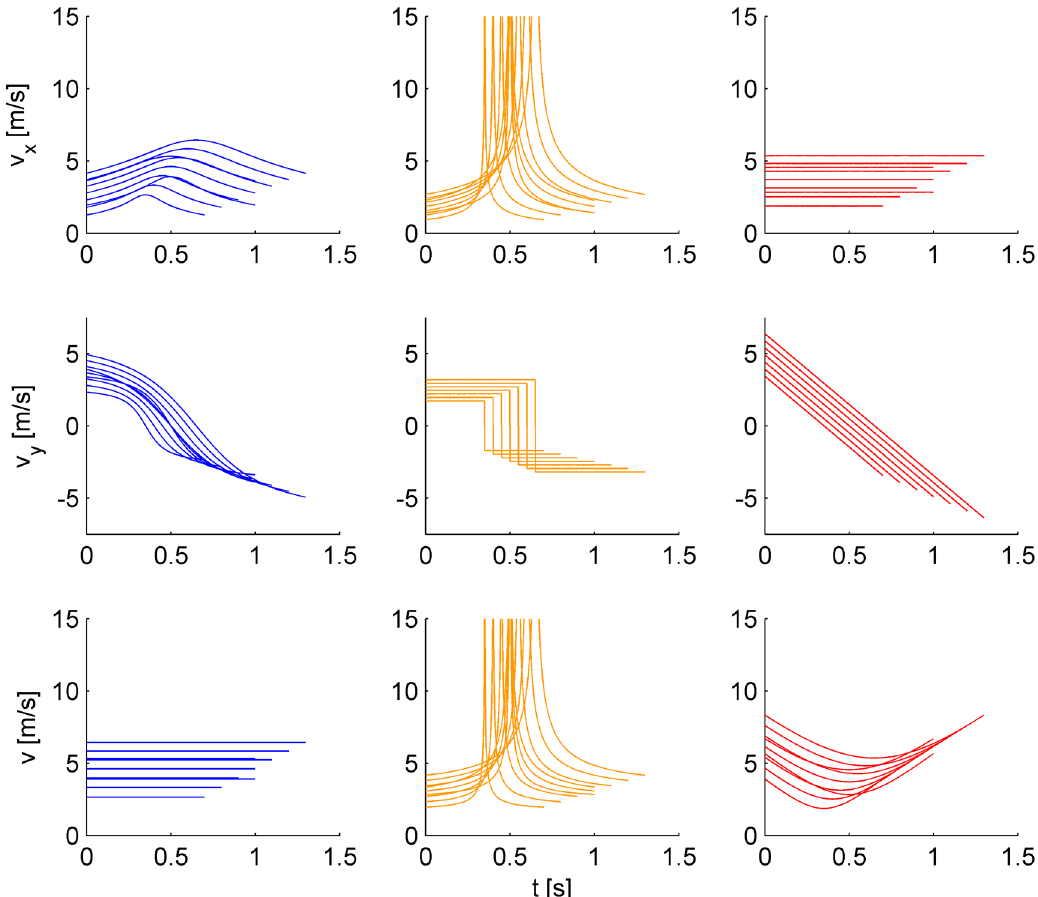
Figure 2. Time course of horizontal velocity (v x ), vertical velocity (v y ) and tangential velocity (v) for conditions #1-#9. Blue, orange and red curves correspond to the three laws of motion, constant tangential velocity, constant vertical velocity, and gravitational acceleration, respectively. The different lines in each panel correspond to the different conditions of motion two stimuli may not be discriminable based on the rate of change of elevation angle 29 . The opposite would apply for high values of DI.